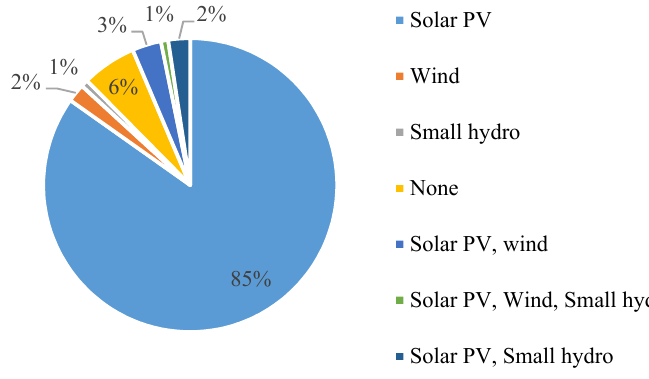
Figure 4. Households’ renewable energy technology choices.